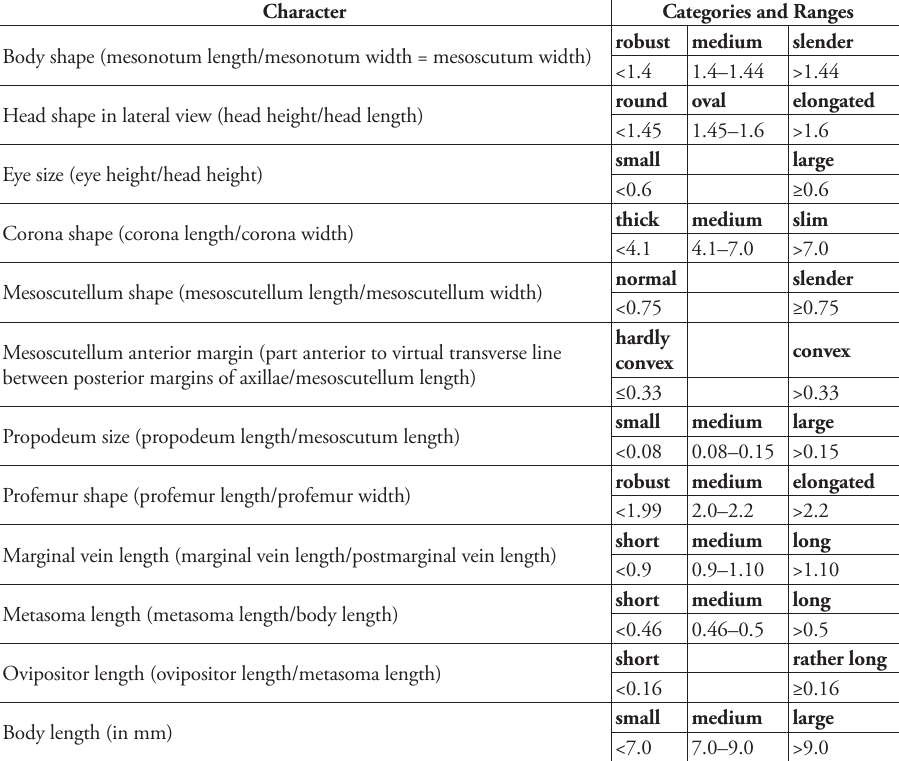
Table 2. Characters and categories used in the text, with respecitive ranges of measured ratios. Character Categories and